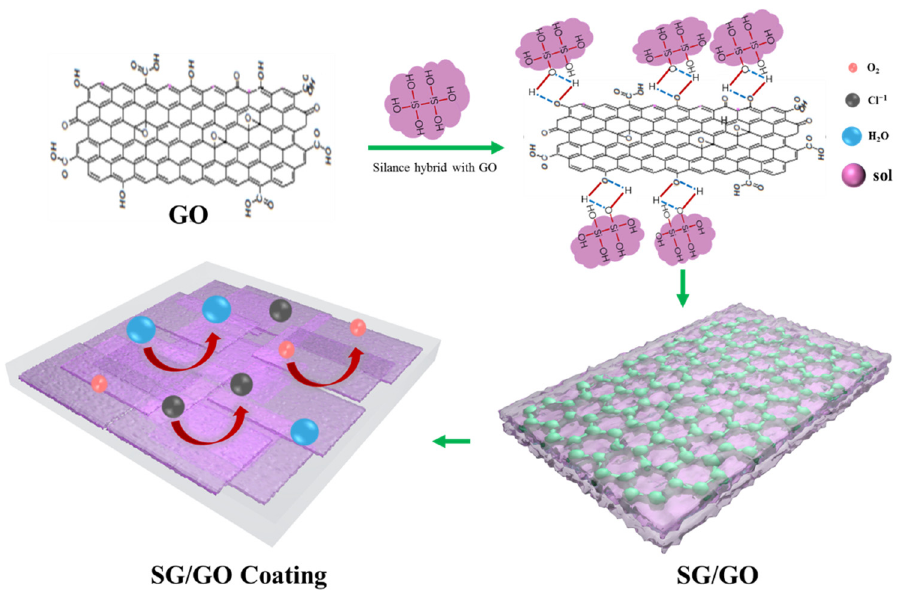
Figure 7. Schematic illustration of formation and corrosion protection mechanism of the coated samples.